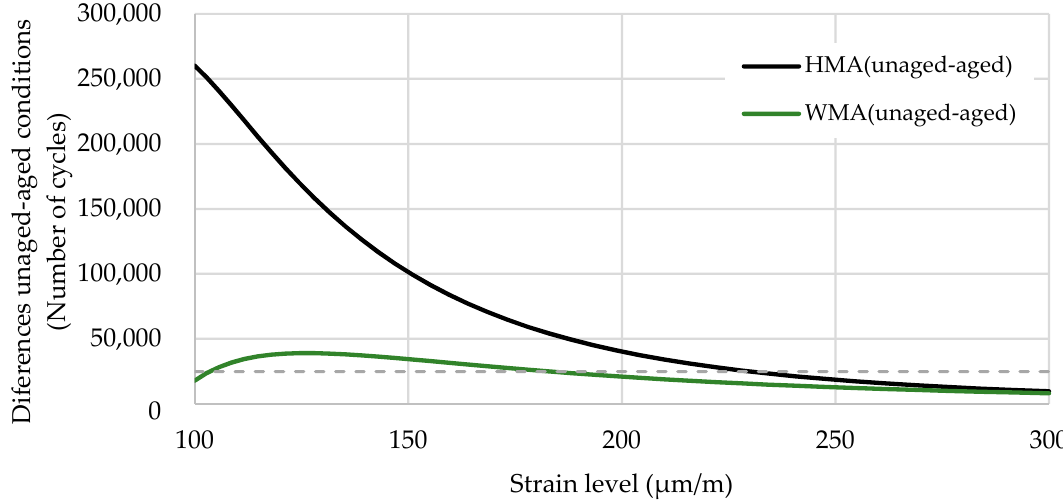
Figure 11. HMA and WMA sensitivity to aged condition varying strain level.